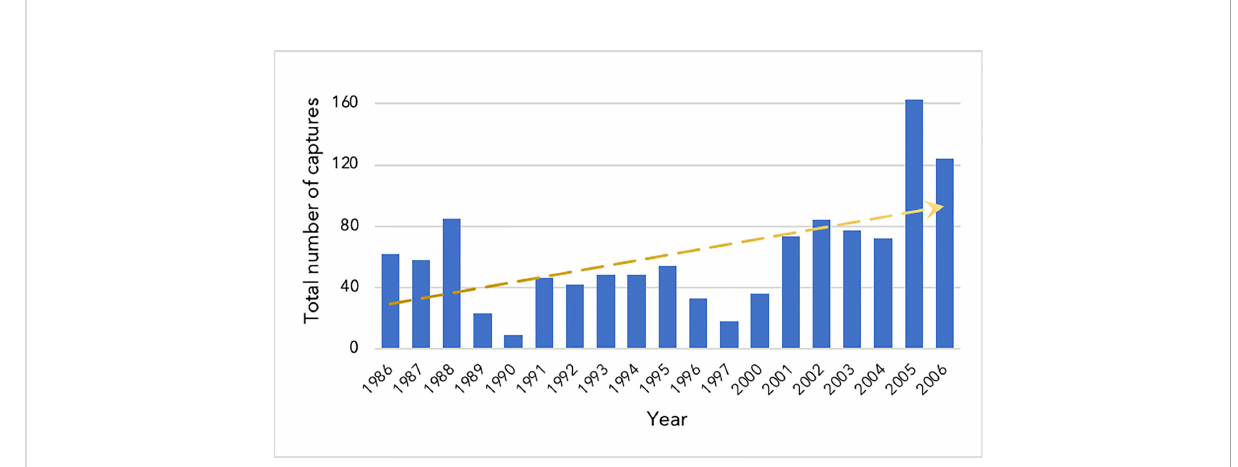
FIGURE 5 Hector ’ s dolphin count in the Banks Peninsula Marine Mammal Sanctuary. Source: Own elaboration, data amended from Gormley et al.